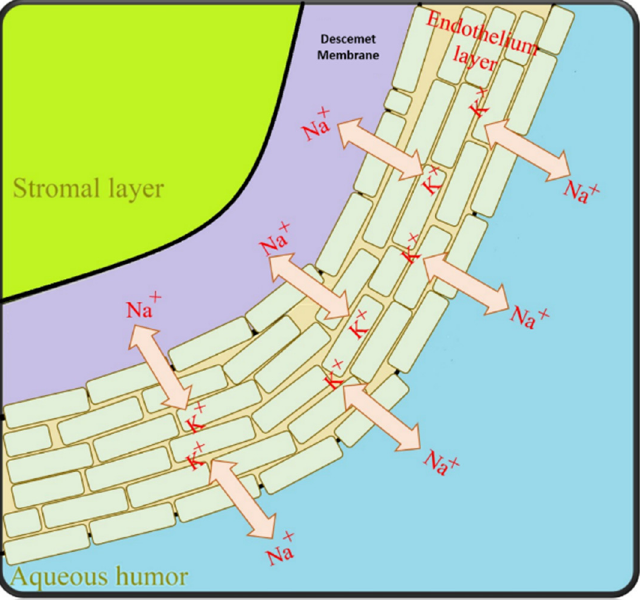
Figure 3. The corneal endothelial “pump-leak” hypothesis illustrated—basic principles